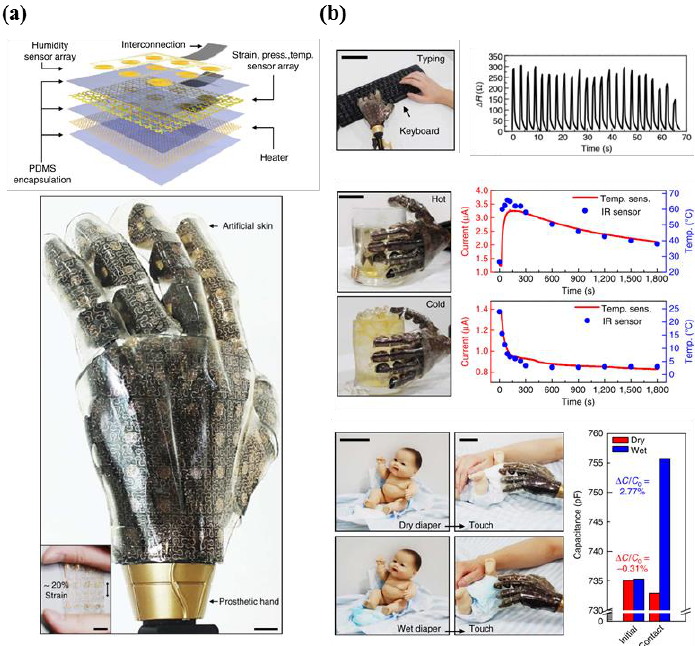
Figure 12. ( a ) Description of the sensor structure (top), image showing the prosthetic hand that is covered with artificial skin. The inset indicates the stretchability of device; ( b ) photograph of tapping keyboard by using prosthetic hand (top left). The changes in resistance of the silicon nanoribbon pressure sensor as a function of time (top right). Photograph of experiment using hot and cold glass (middle left). Real-time monitoring of current change (temperature and IR sensor) (middle right). Image of experimental setup for measuring the humidity sensing capabilities of sensor (bottom left). A bar plot indicating the capacitance change in case of dry and wet states (reprinted with permission for Figure 12a,b from Ref. [139] Copyright 2014 Springer Nature).